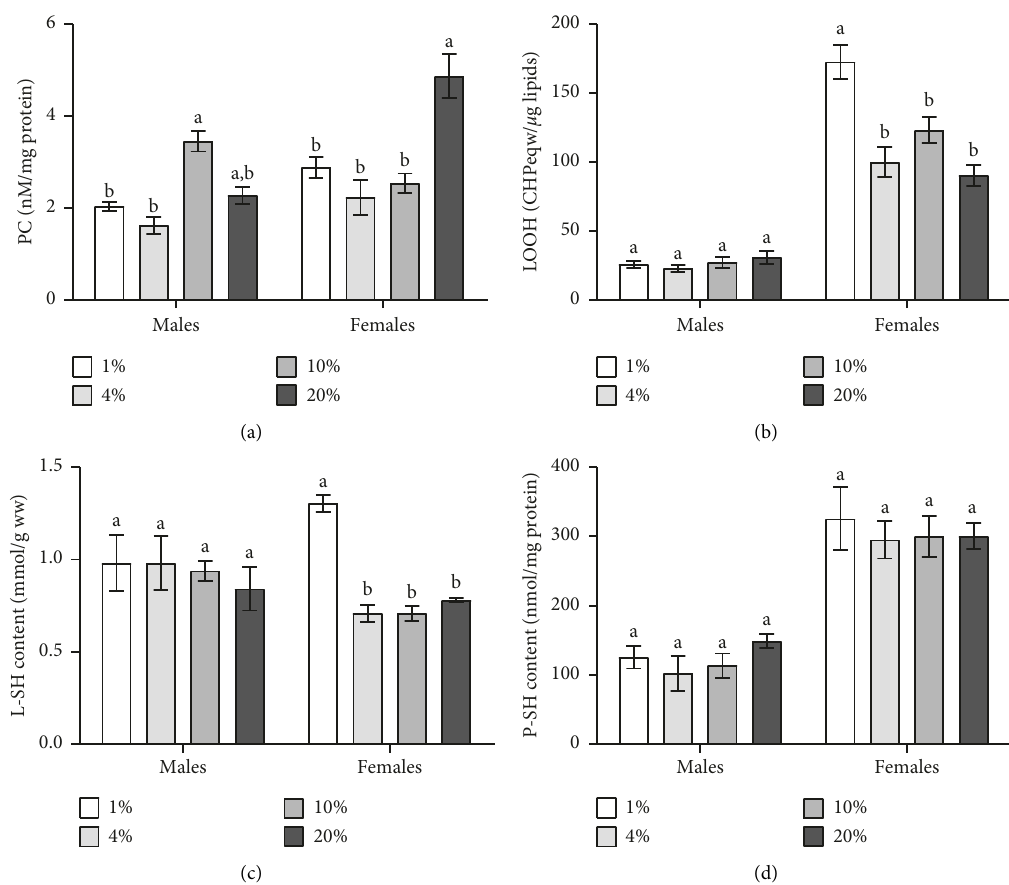
Figure 5: Contents of carbonyl protein, lipid peroxide, low-molecular mass, and protein thiol groups in 25-day-old adult D. melanogaster that are fed with diets containing different sucrose concentrations. Results are shown as mean ± SEM, n � 4. Values were compared by Tukey’s test: a indicates the highest mean among all tested groups; b indicates a significant difference from a with p < 0 . 05. CHP, cumene